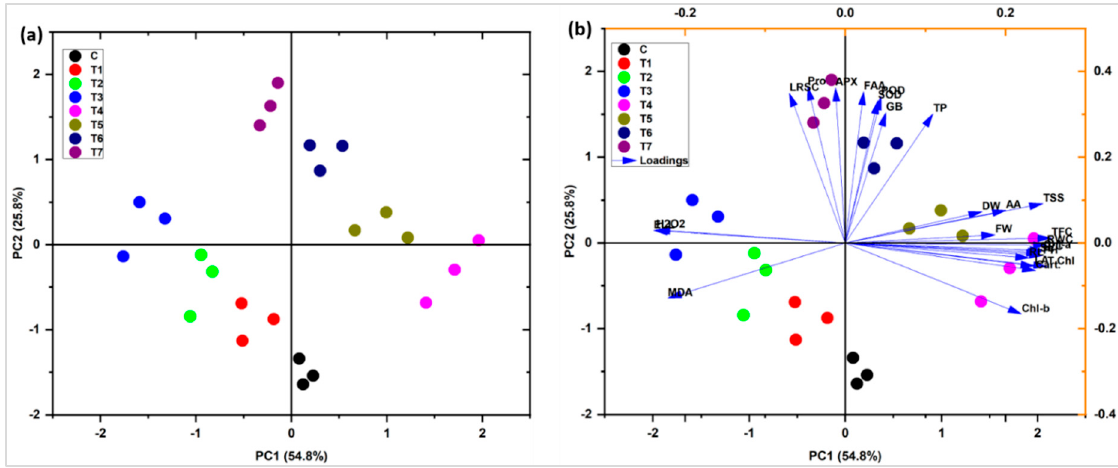
Figure 8. Categorization of E. cloacae PM23 based on its effects on maize growth-promoting characteristics under salinity stress ( a ) Cluster analysis ( b ) PCA Biplot analysis.